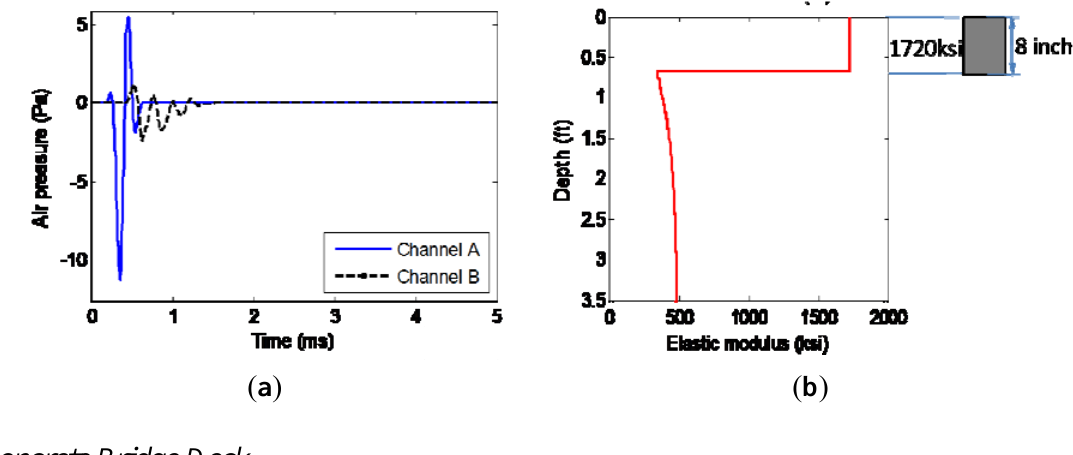
Figure 12. Concrete slab test results. ( a ) Extracted radiating surface wave. ( b ) Estimated elastic modulus